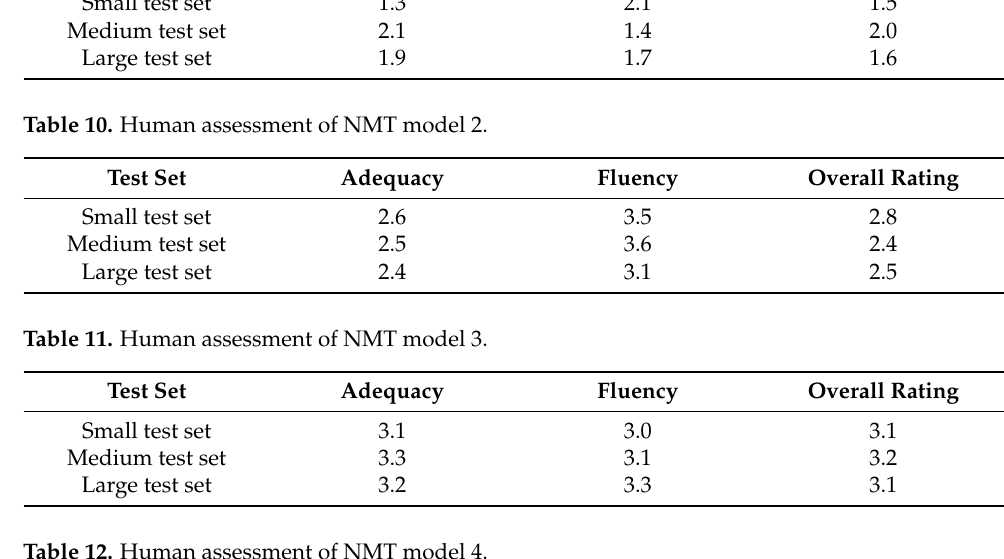
Table 12. Human assessment of NMT model 4.